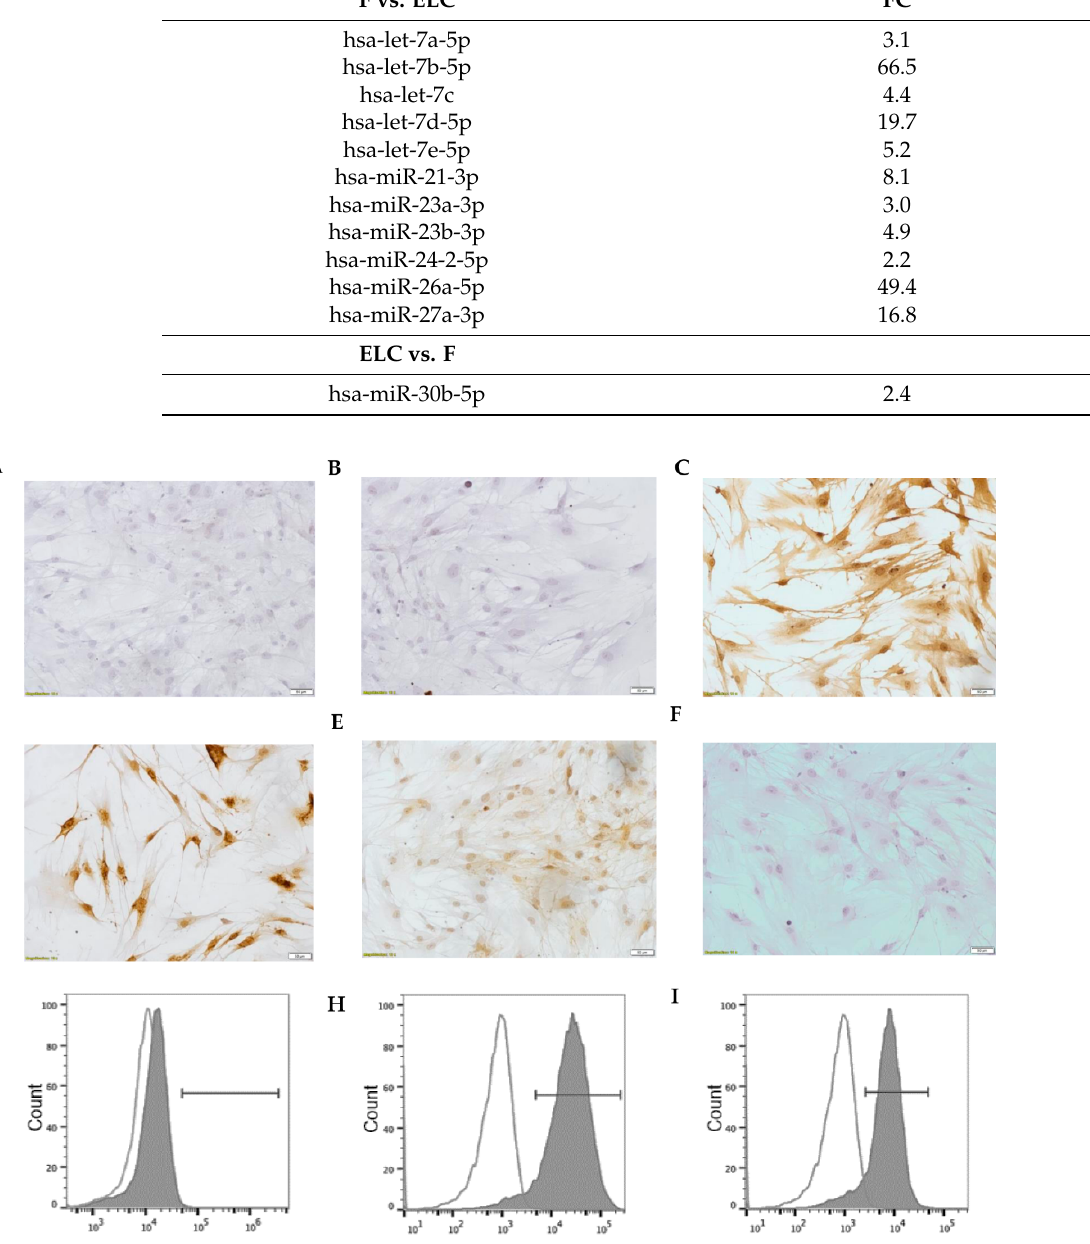
Table 3. The miRNAs overexpressed in MVs derived from fibroblasts compared with those from ELC. Fold changes are indicated (FC). F: fibroblast; ELC: epithelial-like cell. F vs. ELC